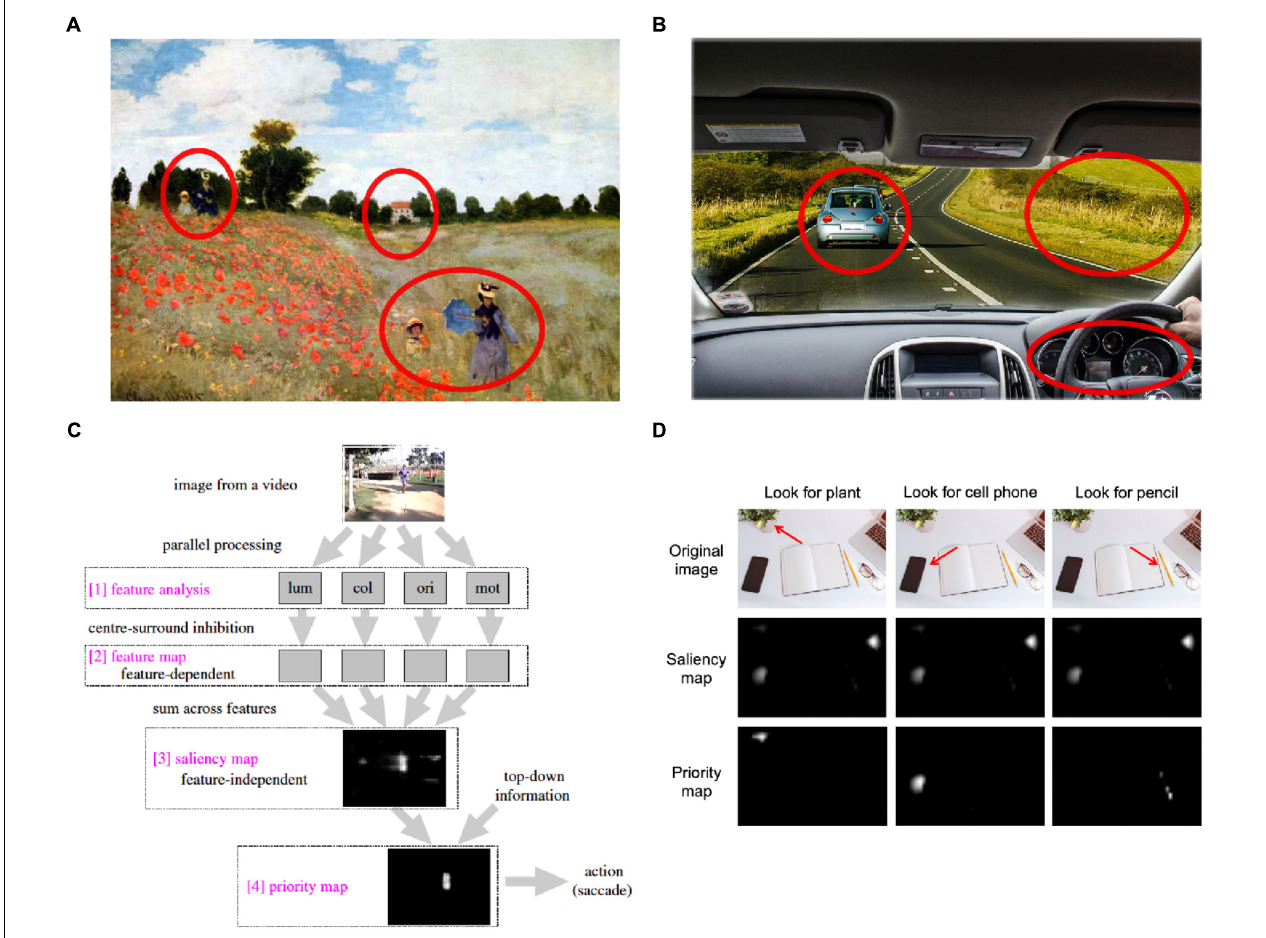
FIGURE 1 | (A,B) Sample visual scenes with red circles indicating different locations where gaze can be directed. Photographic reproduction of painting “Poppies” by Claude Monet (A) , and original image published by Max Pixel under the Creative Commons CC0 License (B) . (C) Feature, saliency and priority maps